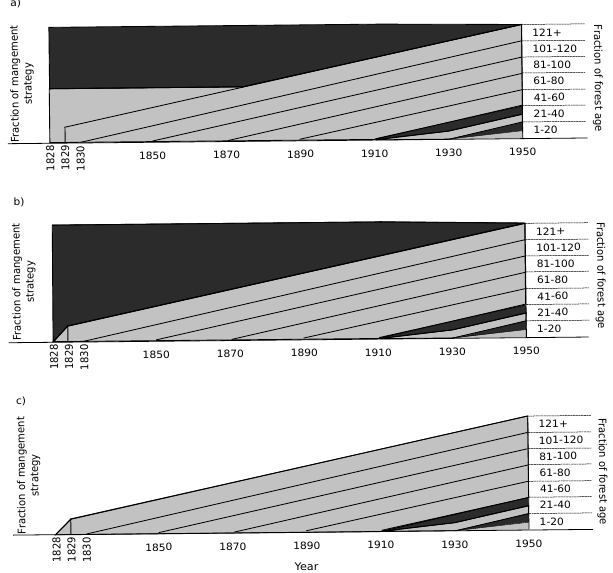
Figure 1. Conceptual presentation of the common forest manage- ment transitions at the pixel level and how these transitions were dealt with in the reconstruction. (a) In 1828 the demand–supply ap- proach resulted in more high stands than expected from the back- casting method. (b) The surface area of high-stand forest in 1828 is less than expected based on backcasting. (c) No coppice manage- ment in 1828 based on demand–supply, but there is coppicing in 1829 based on backcasting. Dark grey shows coppice management; light grey shows high-stand